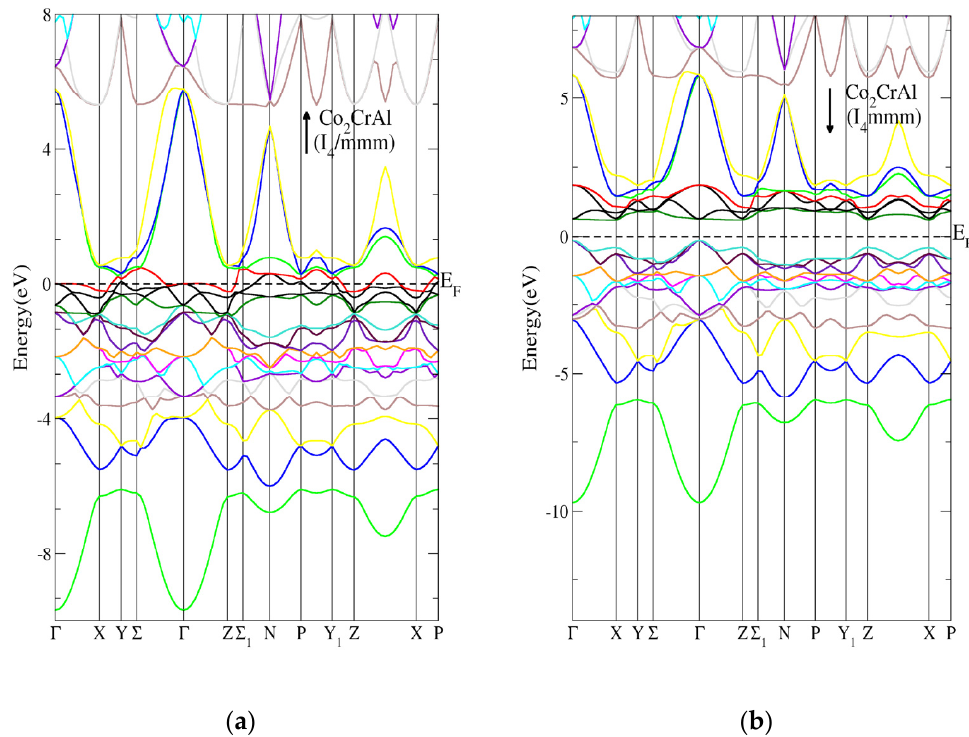
Figure 12. The band structure for the tetragonal I4/mmm (139) Heusler Co 2 CrAl compound in AFM state. ( a ) Spin-up tetragonal I4/mmm Heusler (139) Co 2 CrAl compound and ( b ) spin-down tetragonal I4/mmm Heusler (139) Co 2 CrAl Table 7. The energy band gaps for the tetragonal I4/mmm (139) Heusler Co (cid:2870) CrAl and Cr (cid:2870) MnSb com- pounds in AFM state.